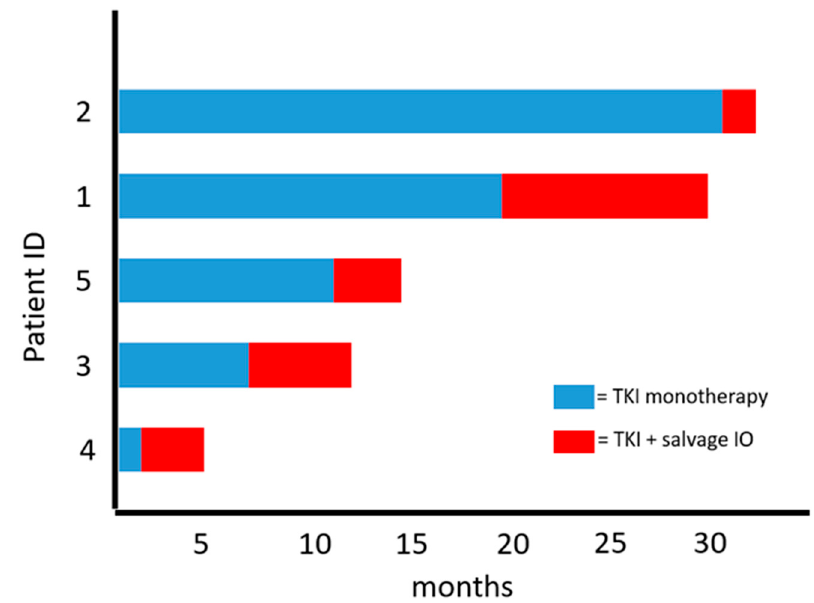
Figure 1. Duration on TKI monotherapy and with TKI and salvage IO.